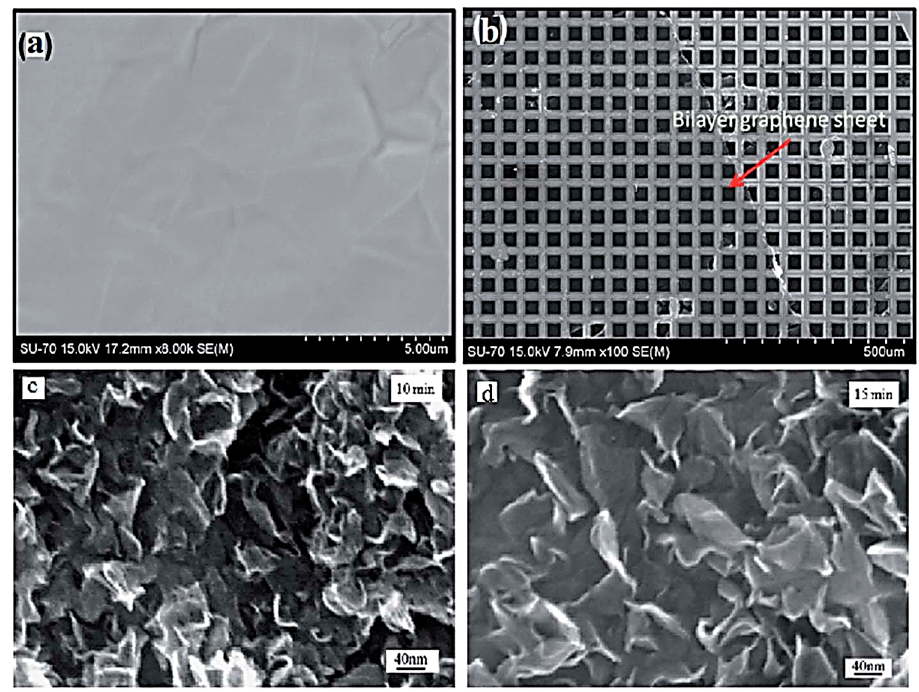
Figure 7. ( a ) FESEM micrographs of Gp sheets grown on copper, ( b ) FESEM micrograph of a double layer Gp sheet on a copper grid, produced by hot filament thermal chemical vapor deposition (high magnification). FESEM micrographs of Gp at ( c ) 10 min and ( d ) 15 min growth times Reprinted with permission from [60]. Copyright RSC Publishers,